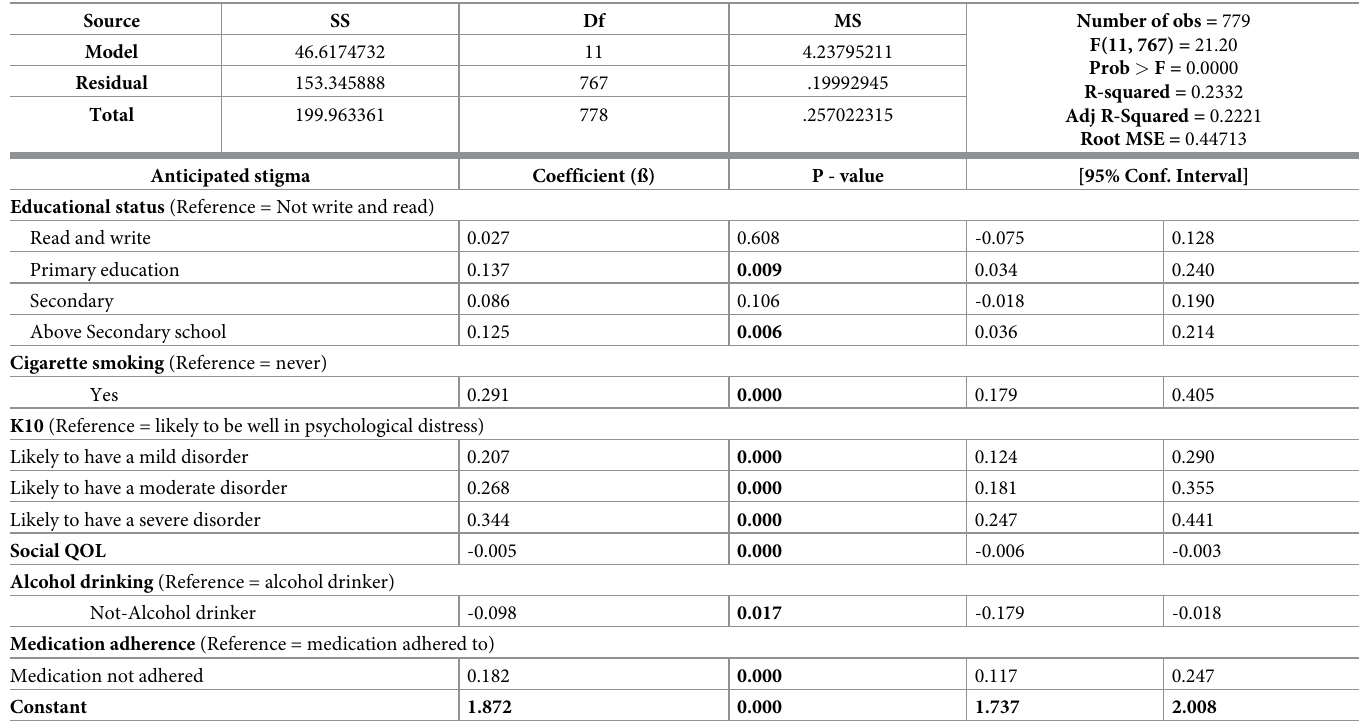
Table 4. Factors associated with anticipated stigma among patients with chronic illness in three Amhara Region Referral Hospitals, Northwest Ethiopia (n =